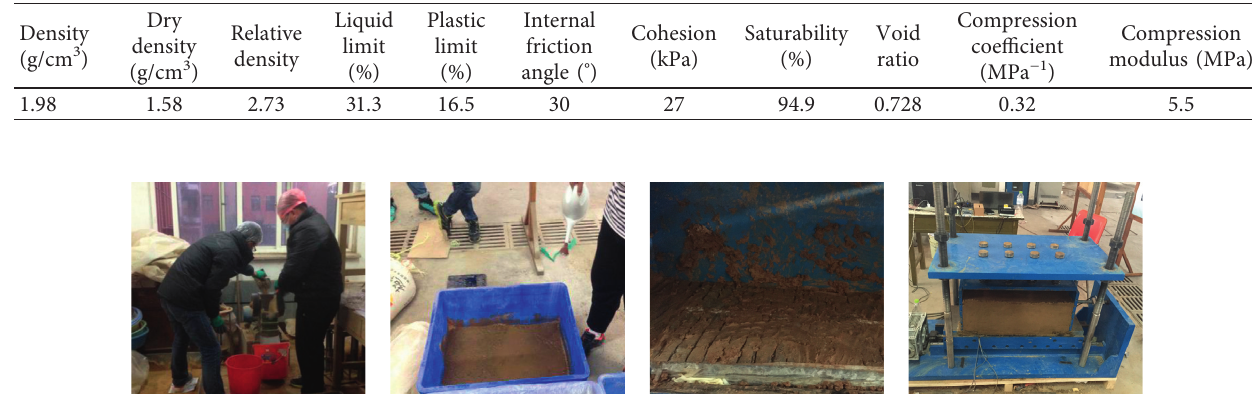
Figure 5: Work curves of silicon piezoresistive soil pressure sensor under different pressures. (a) Up stroke. (b) Down stroke. Table 2: Soil physical properties indicators.